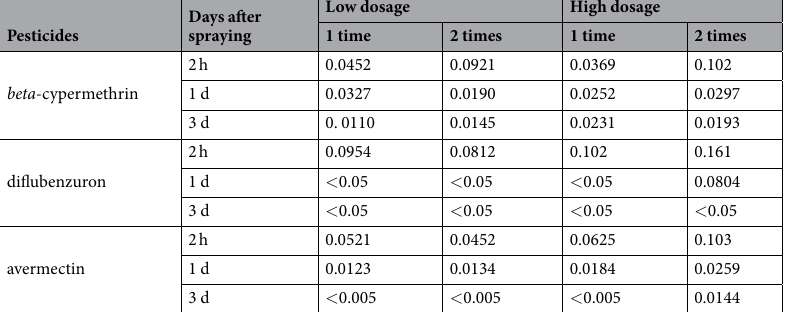
Table 4. Terminal residues of beta -cypermethrin, diflubenzuron and avermectin in button